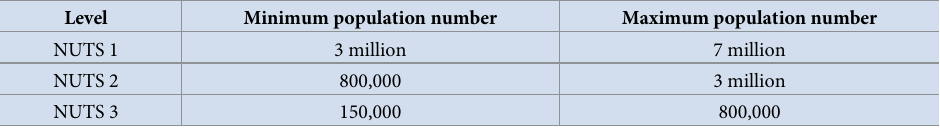
Table 1. NUTS classification for development